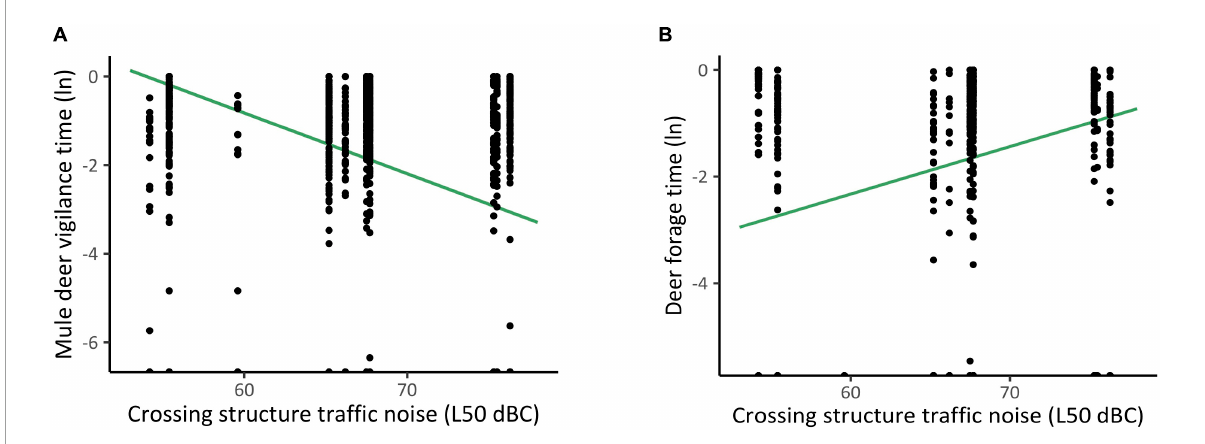
FIGURE4 Proportion of time mule deer spent being (A) vigilant and (B) foraging at crossing structures with differing chronic (1 week) noise levels (black dotes). To capture the estimated effect of chronic noise independent of other covariates, the line of best fit was generated using a predictive